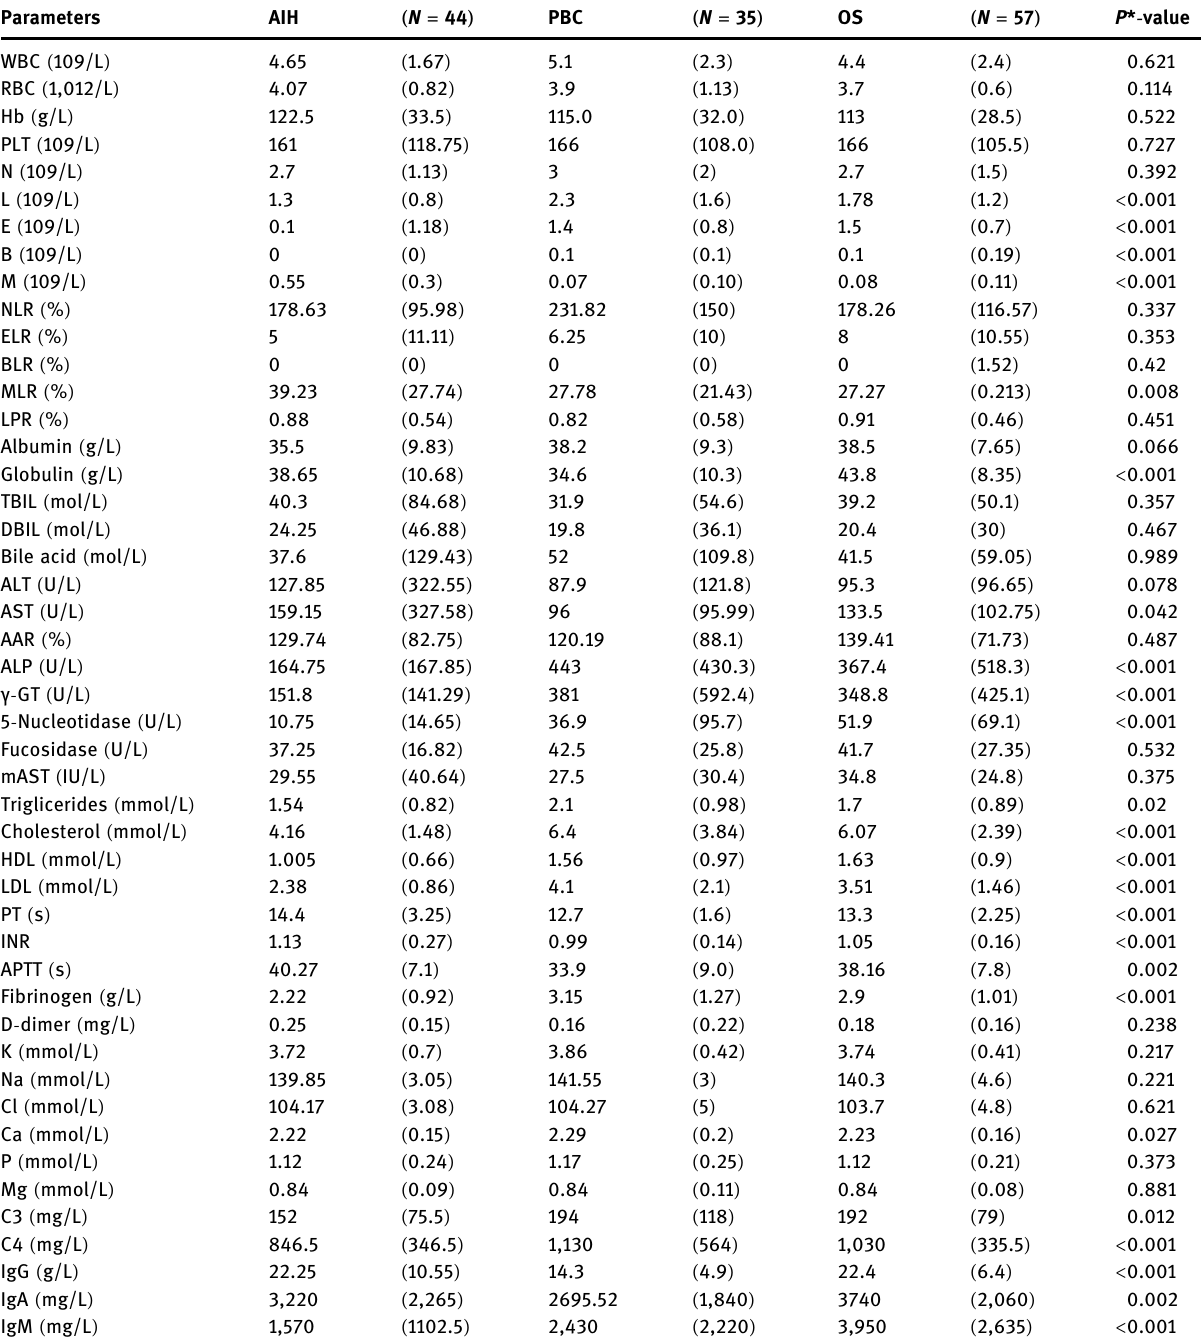
Table 2: Blood indexes of patients studied